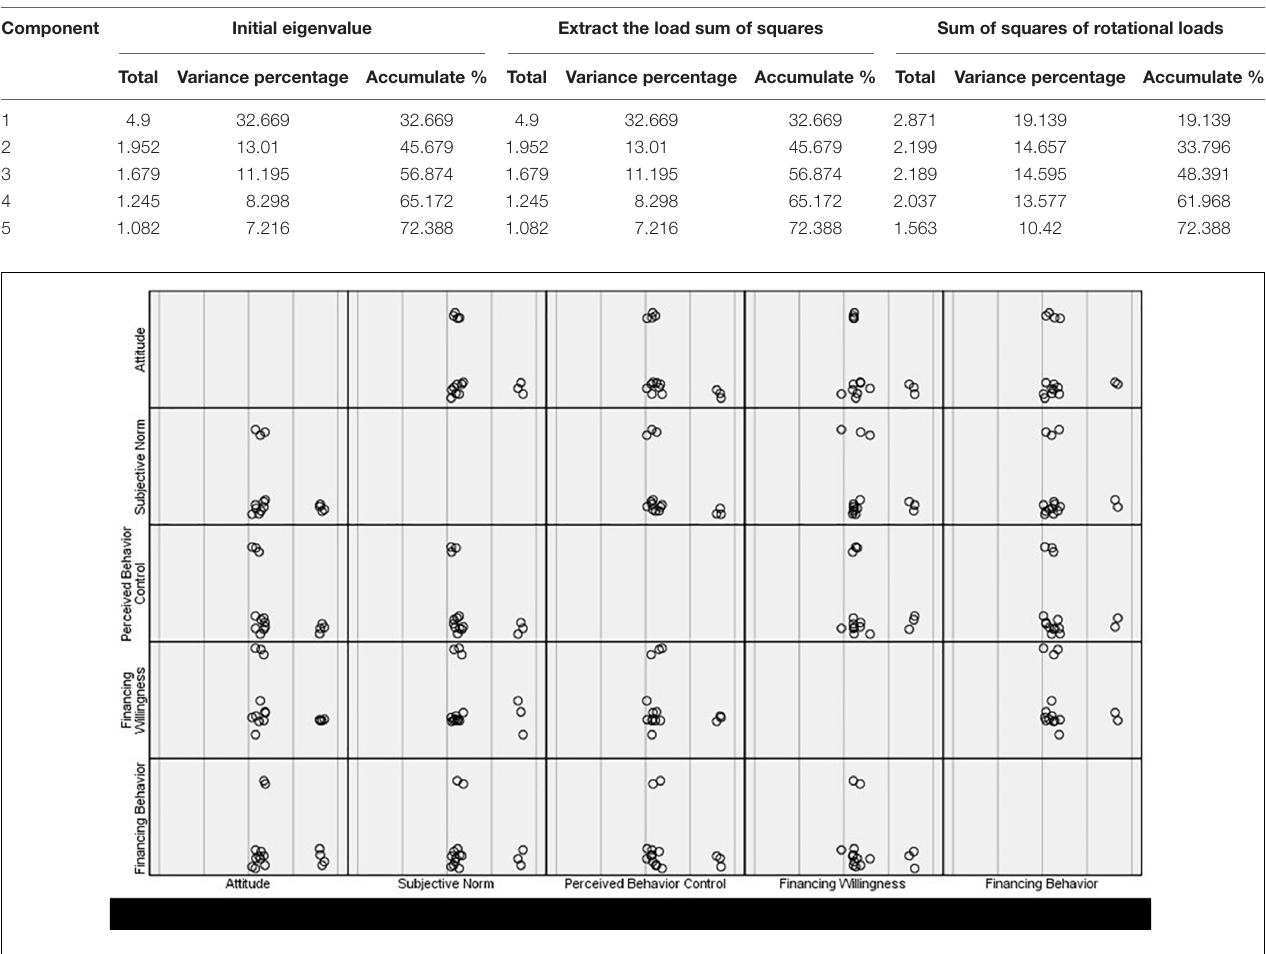
TABLE 4 | Results of principal component analysis.